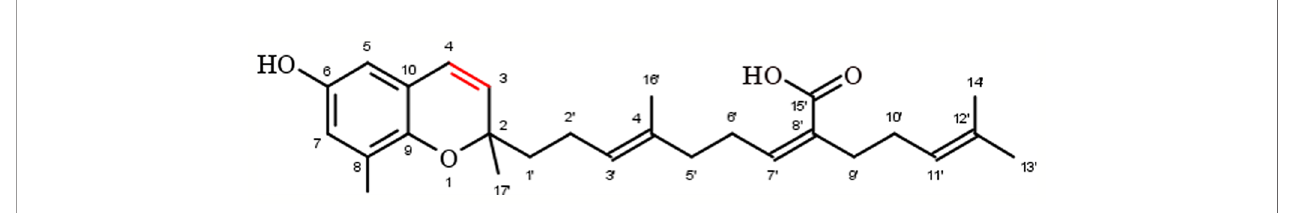
FIGURE 6 | Molecular structure of